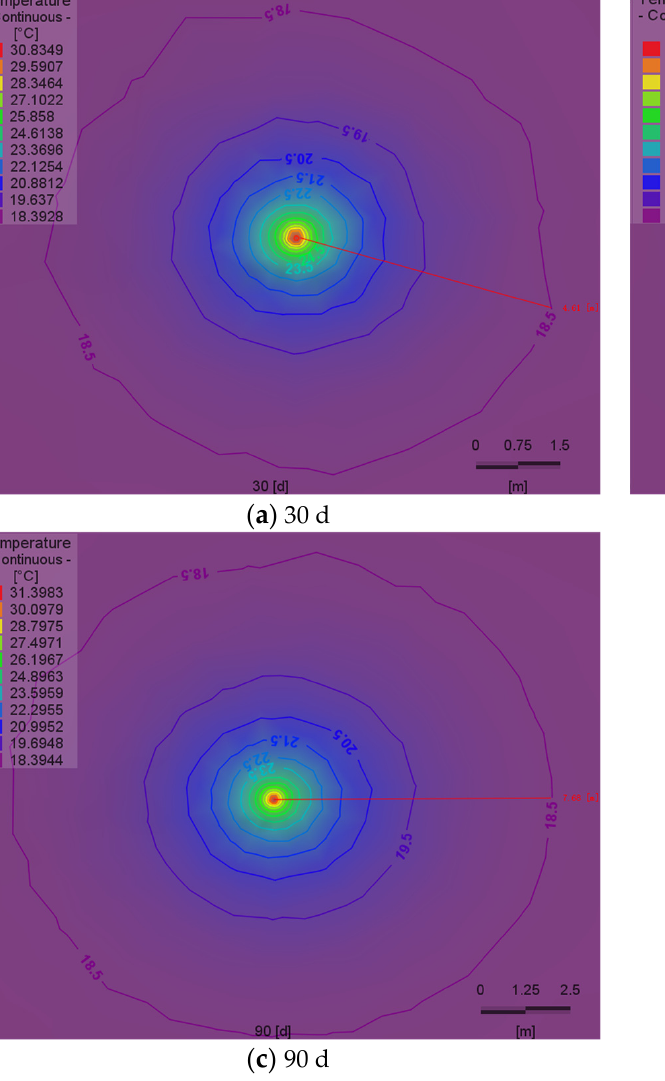
Figure 4. Ground temperature field diagram around the BHE during the refrigeration period under the operation of a single BHE.